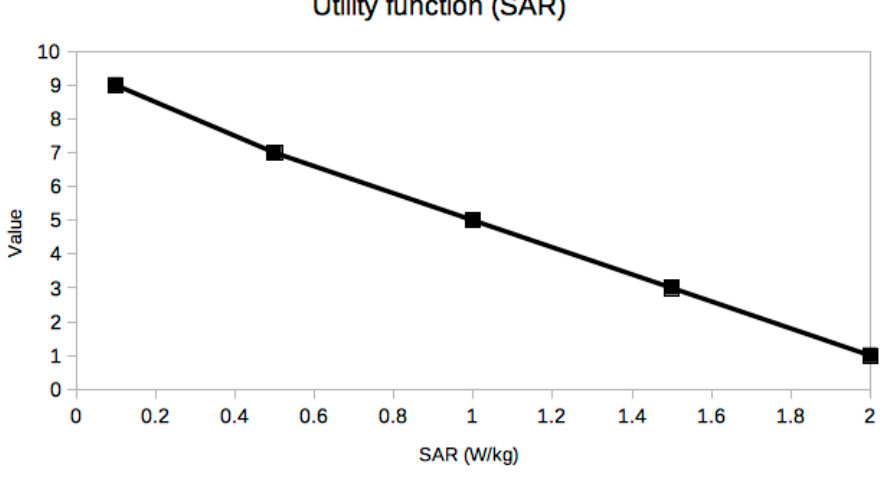
Figure 8. Utility function for Specific Absorption Rate.